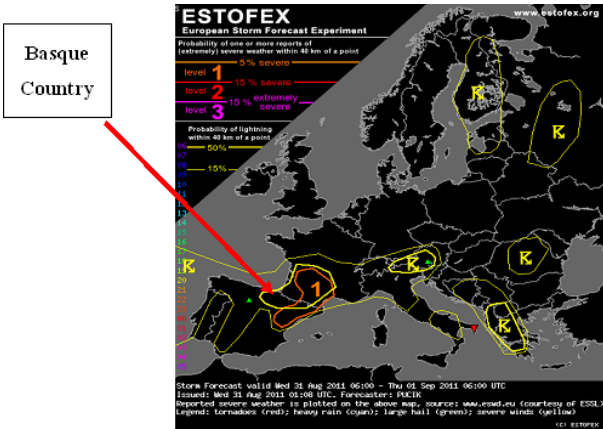
Fig. 1. Location of the Basque Country and meteorological alerts addressed by Estofex on 31 August